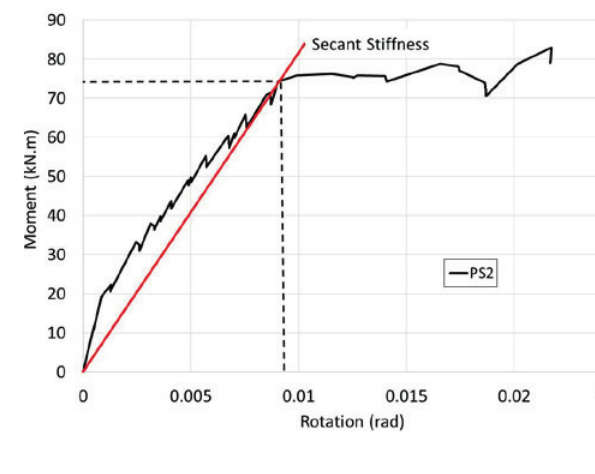
Figure 24 – Moment-rotation curve: specimens PS1 and